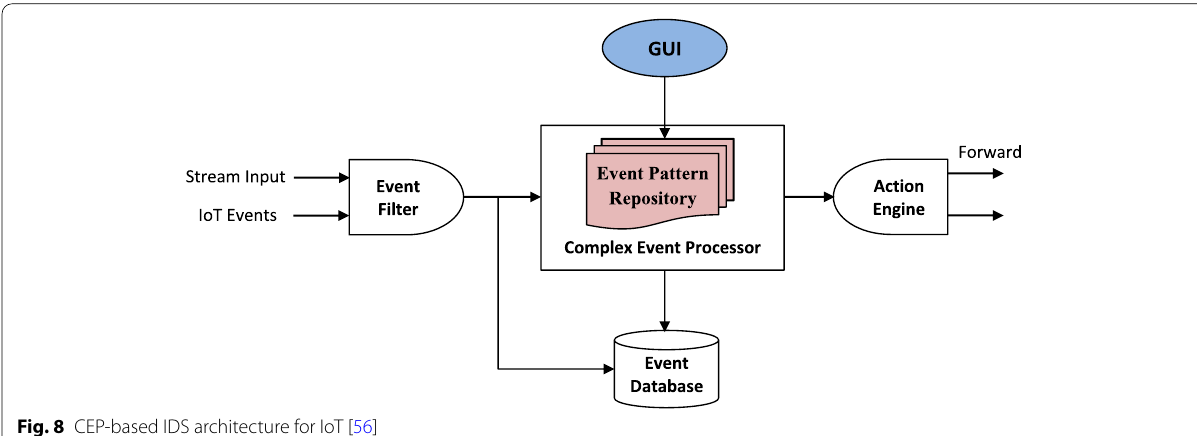
Fig. 8 CEP-based IDS architecture for IoT